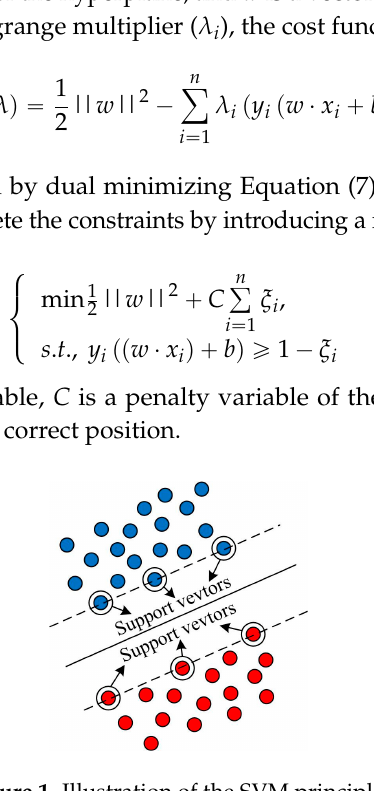
Figure 1 . Illustration of the SVM principle. Figure 1. Illustration of the SVM